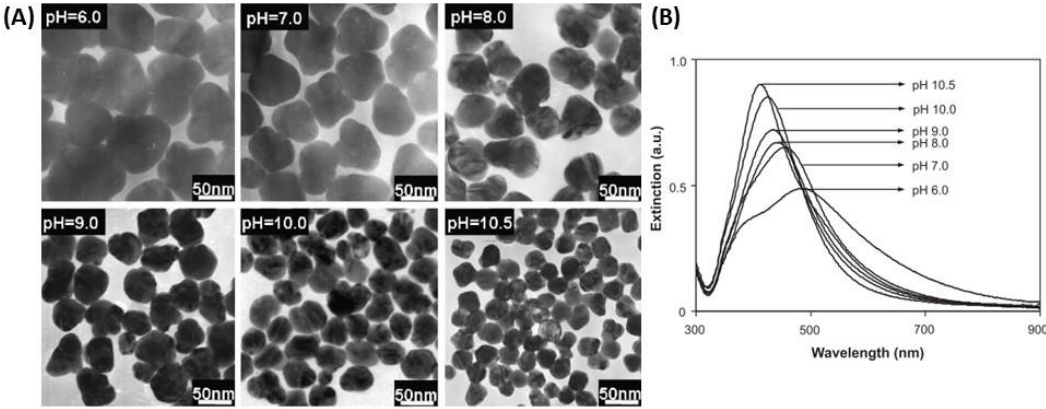
5 of 40 Figure 1. AgNPs synthesis using citrate: ( A ) Experimental conditions affecting the silver nanoparticle AgNPs shape and ( B ) TEM images of the AgNPs synthesized at different pH values: (i) 11.1, (ii) 8.3, (iii) 6.1 and (iv) 5.7. Adapted from [72]. Copyright (2009), American Chemical Society. This observation was confirmed by Qin et al. in 2010 as more spherical particles were obtained when the pH was increased by using ascorbate as a reductant and citrate as a stabilizer [73]. Furthermore, they demonstrated that NP size varied as a function of pH. Indeed, AgNPs were smaller due to the increased reducing activity of citrate or ascorbic acid (AA) when the pH